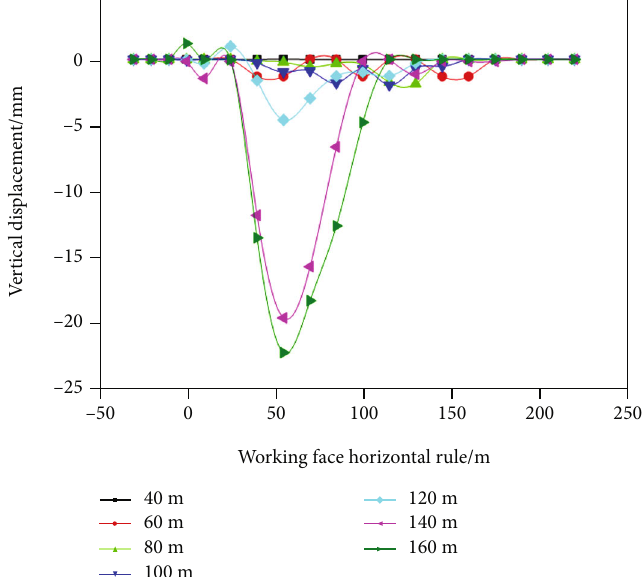
Figure 6: Dynamic subsidence curve of No. 1 line in the process of 1200m deep mining